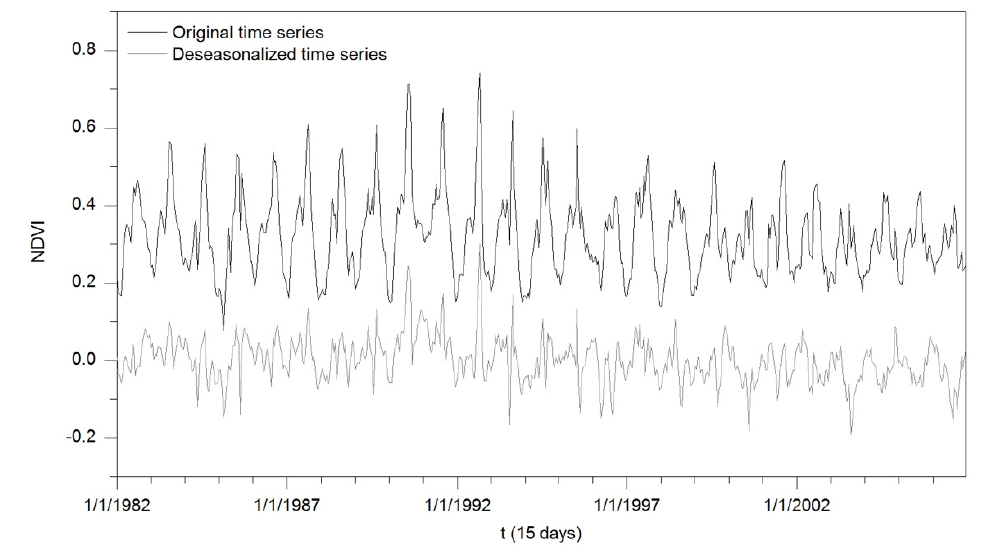
Figure 1. Characteristic fluctuation of the original and deseasonalized GIMMS NDVI time series for one arbitrary pixel from 1982 to